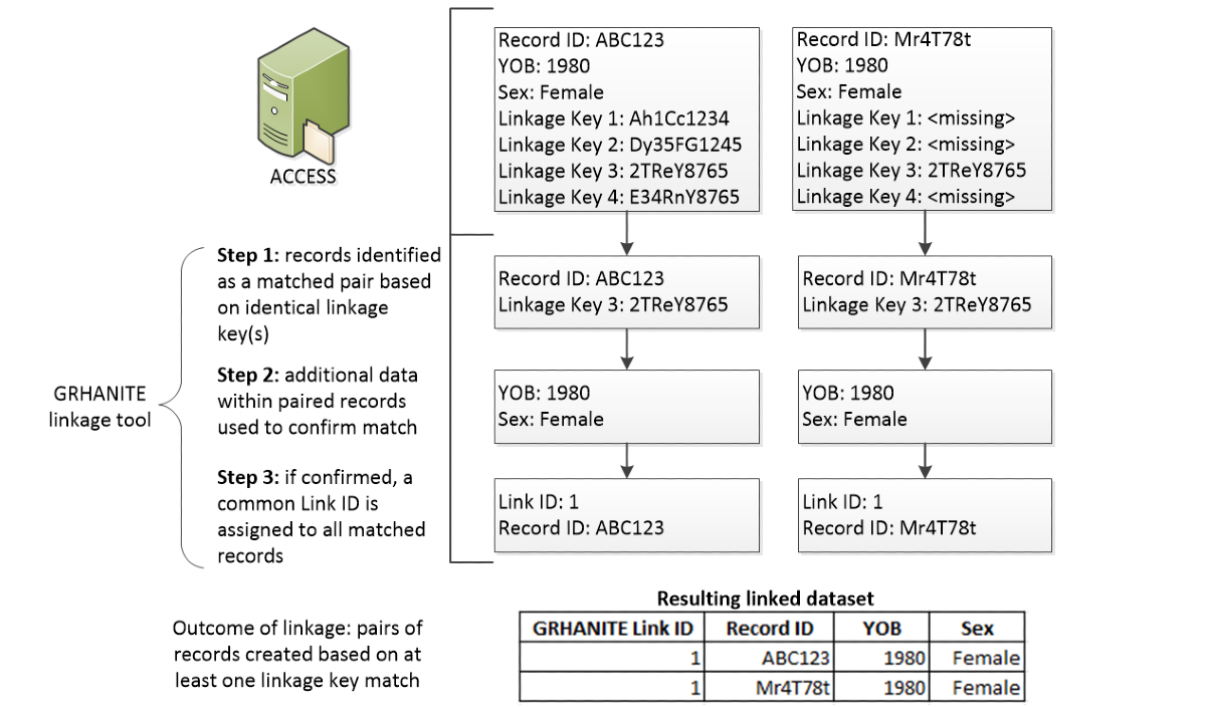
Figure 2. Record linkage in the Australian Collaboration for Coordinated Enhanced Sentinel Surveillance: using the GRHANITE Linkage Tool to identify and accept